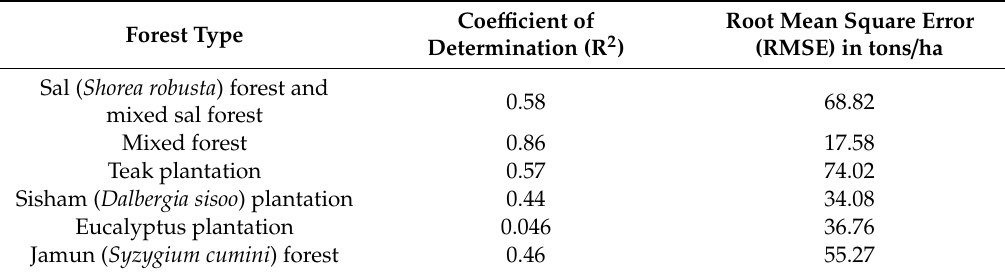
Figure 15. Relationship between the field-estimated AGB and the modeled AGB for: ( a ) sal forest and mixed sal forest, ( b ) mixed forest, ( c ) teak plantation, ( d ) sisham plantation, ( e ) eucalyptus plantation, and ( f ) jamun forest. Table 2. Coe ffi cient of determination and RMSE for the AGB estimation of di ff erent forest types of Dudhwa National Park, Uttar Pradesh,